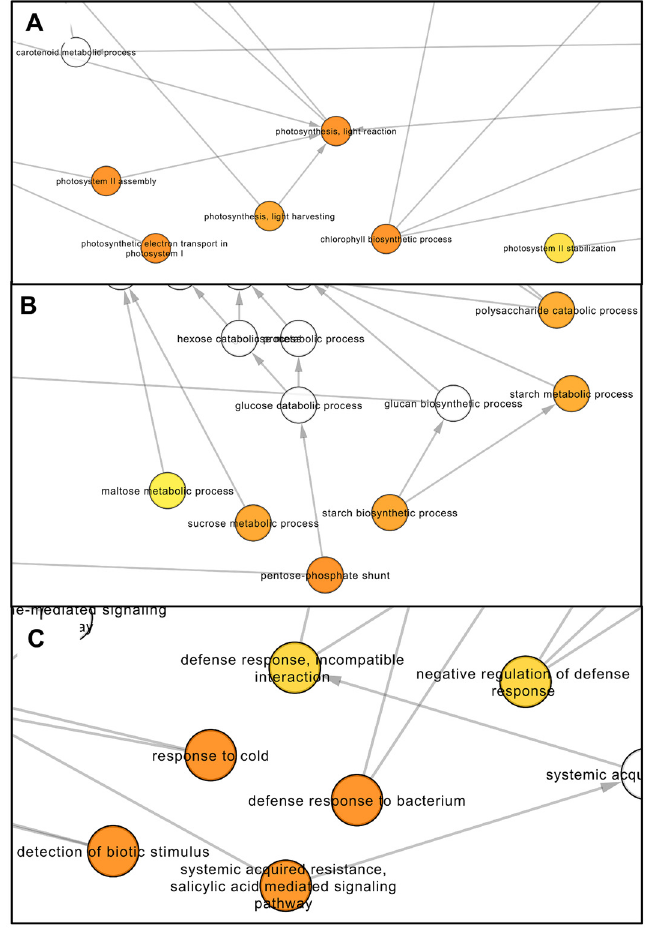
Fig 4. Enriched network based on GO terms in the up-regulated gene dataset associated with photosynthesis (A), carbon metabolism (B) and biotic and cold stress responses (C). Data were analyzed using the Biological Networks Gene Ontology tool (BiNGO). The area of a node is proportional to the number of up-regulated genes annotated to the corresponding GO category. Node color means enrichment significance i . e . darker the color on a color scale ranging from white (no significant) to orange (FDR-corrected p-value = 3 x 10 − 10 ), higher is the enrichment significance. White color nodes are not enriched but show the hierarchical relationship among the enriched ontology